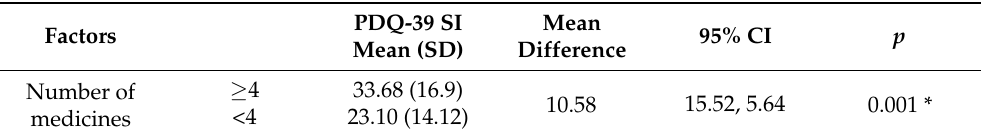
Table 8. Influence of polypharmacy on